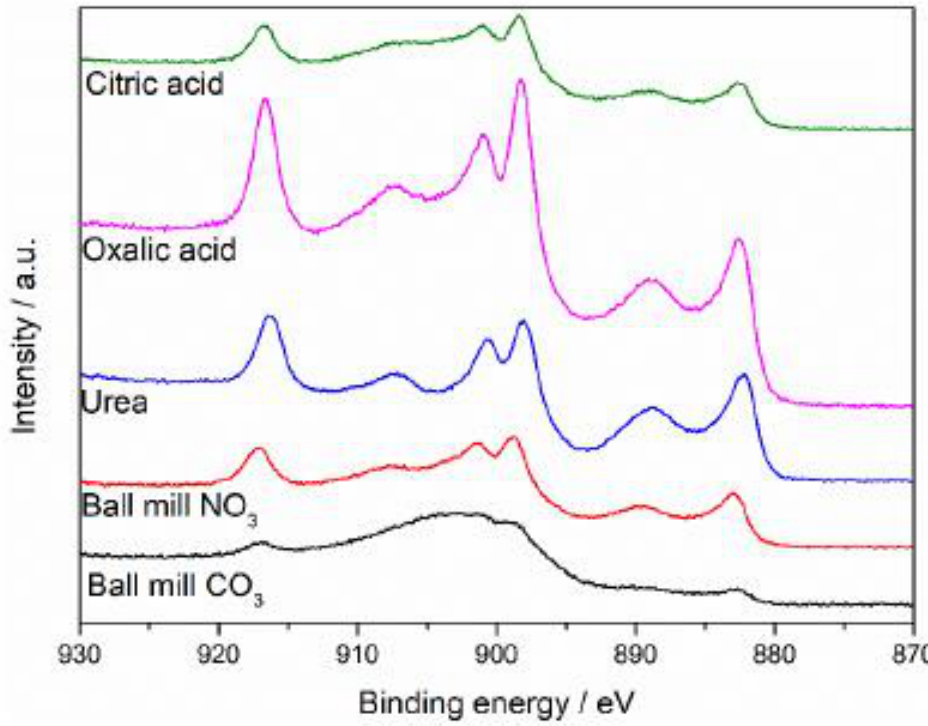
Figure 11. Ce 3d XPS spectra for Ce 0.25 Mn 0.75 O x catalysts.